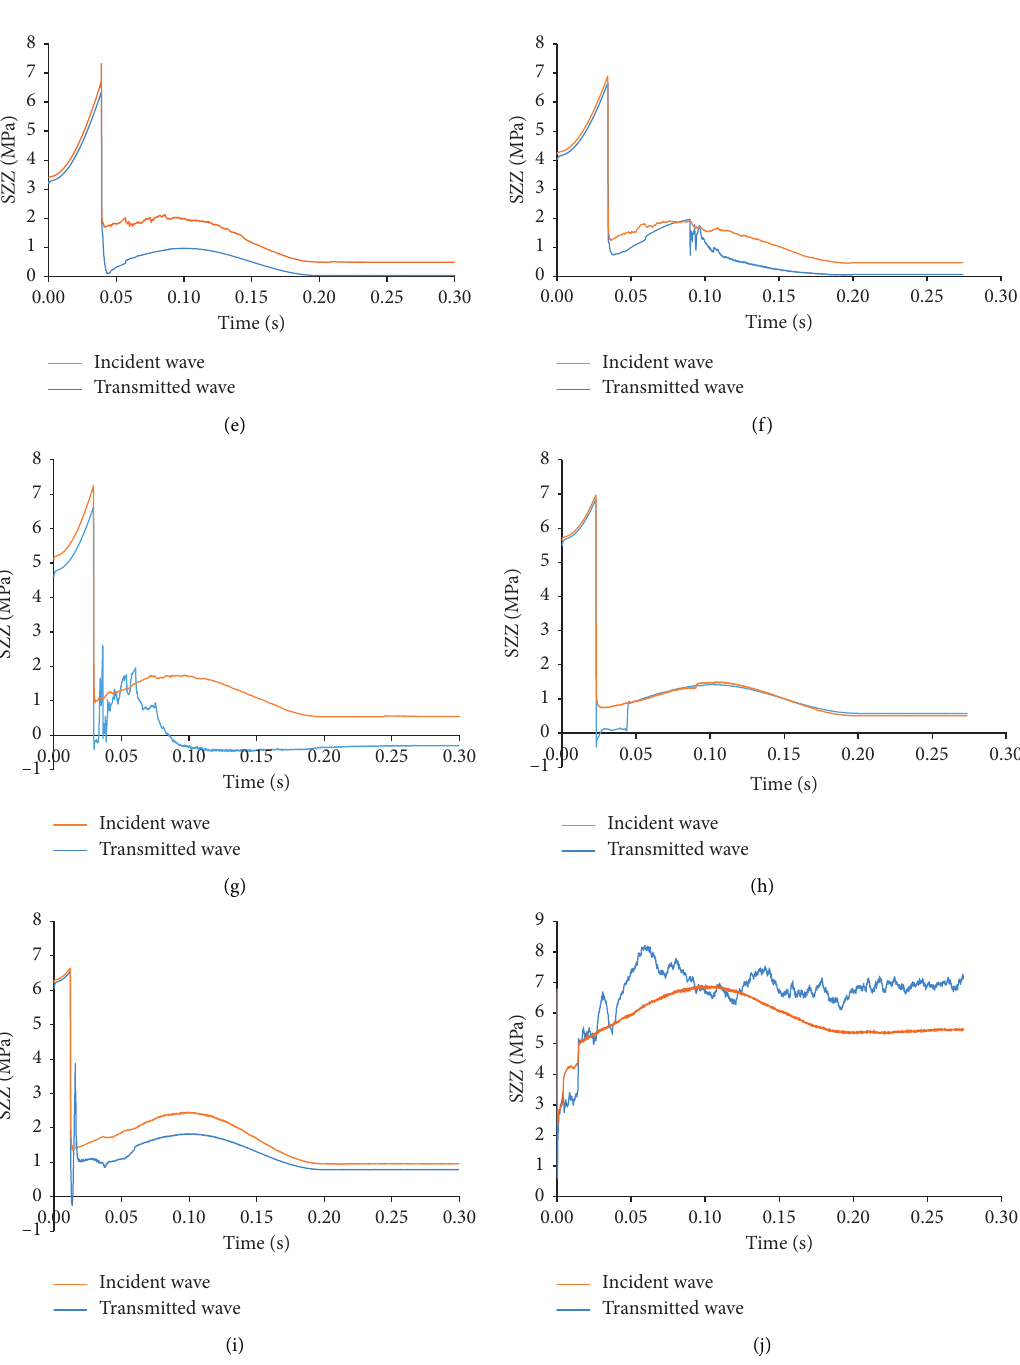
from 1.28 MPa to 3.81 MPa. However, the attenuation of the incident wave stress varies slightly, which trends to be zero when p ≥ 30 MPa. (Figure 15) dm